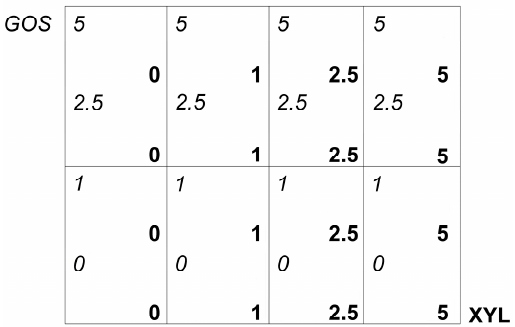
Figure 1. Scheme of Xylitol (XYL) and Galacto-OligoSaccharide (GOS) tested combinations. The OD 600 was measured with an ELISA reader (SAFAS, Munich, Germany) after 3,